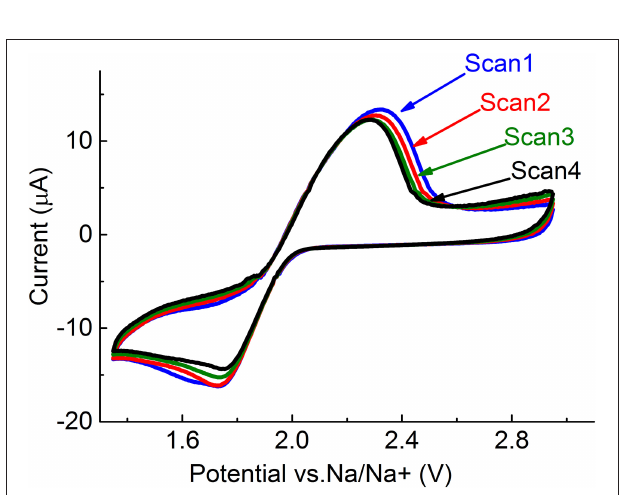
FIGURE 2 | Five first cycles of BP 2000 coated on GC electrode in PEGDME/0.25M NaOTf (Scan rate 5 mV/s) (40 µ g/cm 2 ).